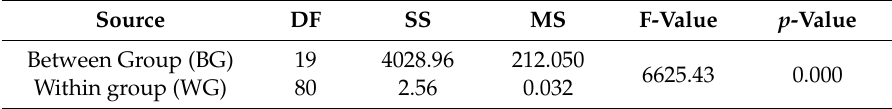
Table 7. The ANOVA test results of flexural